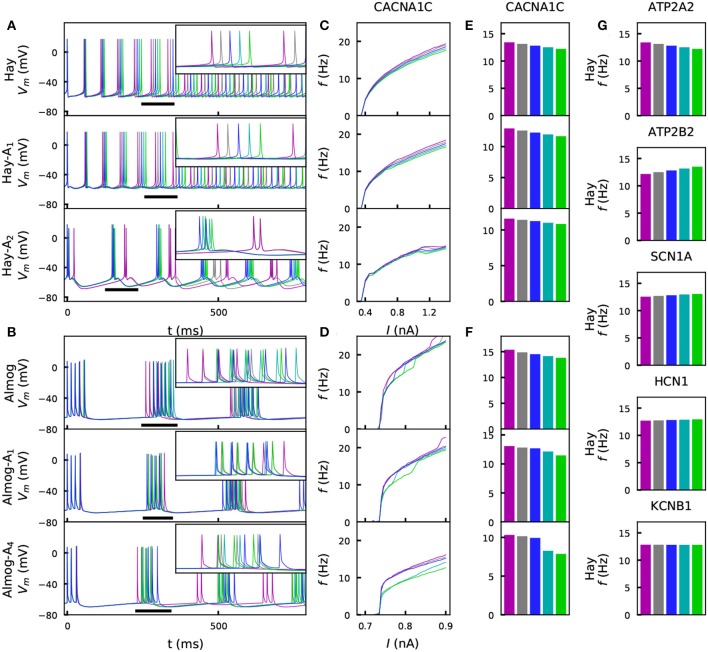
Steady-state firing behavior is affected by the variants. (A) Membrane potential time series of the original Hay model (top panel), and of the altered Hay models Hay-A1 (middle panel) and Hay-A2 (bottom panel). Blue curves show the control neuron behavior, as other colors show the effects of a CACNA1C variant (purple: ϵ=12, gray: ϵ=14, cyan: ϵ=-14, green: ϵ=-12). Insets show a zoomed-in view on the time marked with horizontal black bars. (B) Membrane potential time series of the original Almog model (top panel), and of the altered Almog models Almog-A1 (middle panel) and Almog-A4 (bottom panel). Blue curves show the control neuron behavior, as other colors show the effects of the same CACNA1C variant as in panel (A). (C, D): f-I curves of the CACNA1C model variant of panel (A) according to the unaltered and altered Hay (C) or Almog (D) models. Blue curves show the control neuron f-I curve, and other colors show the different scalings of the variant (see A,B). (E,F) Averages of the f-I curves of unaltered and altered Hay (E) and Almog (F) models across the somatic current amplitudes [integrated across amplitudes 0.3–1.4 nA (C) or 0.65–0.9 nA in (D) and divided by 1.1 nA (C) or 0.25 nA (D)]. (G) Averages of the f-I curves of the Hay model with different variants—see the top panel of (E) for the corresponding data from the CACNA1C variant.